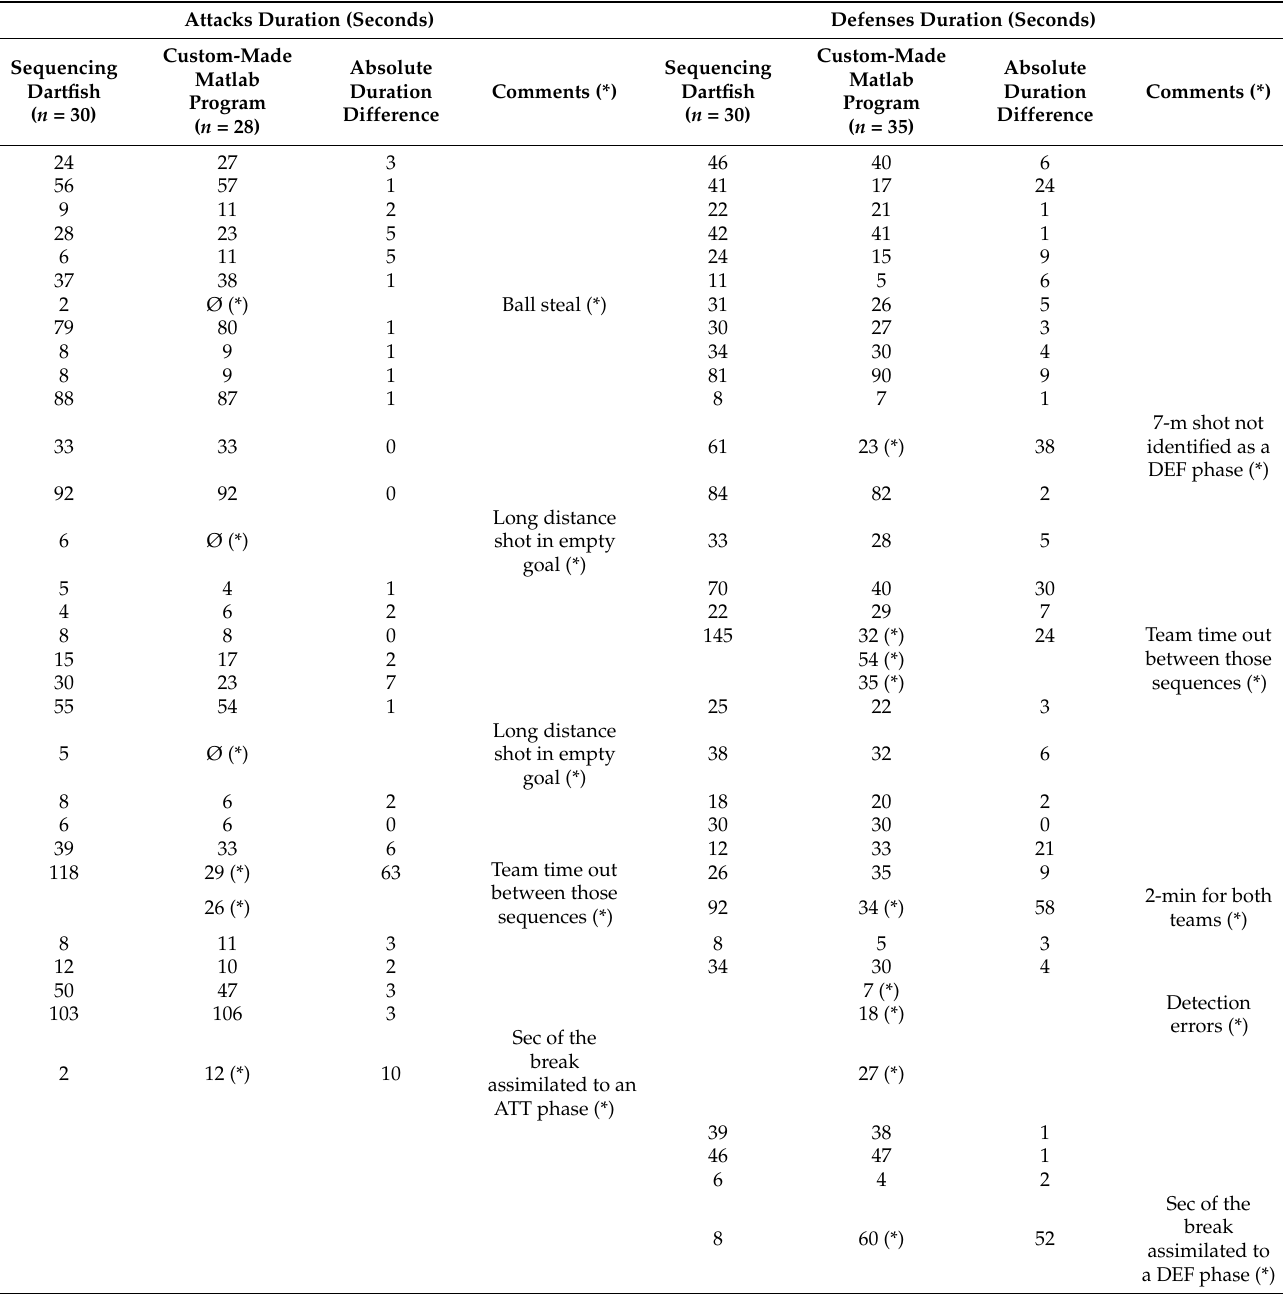
Table A1. First half of the first match of the data validation set. Comparisons between Dartfish sequencing and the custom-made Matlab